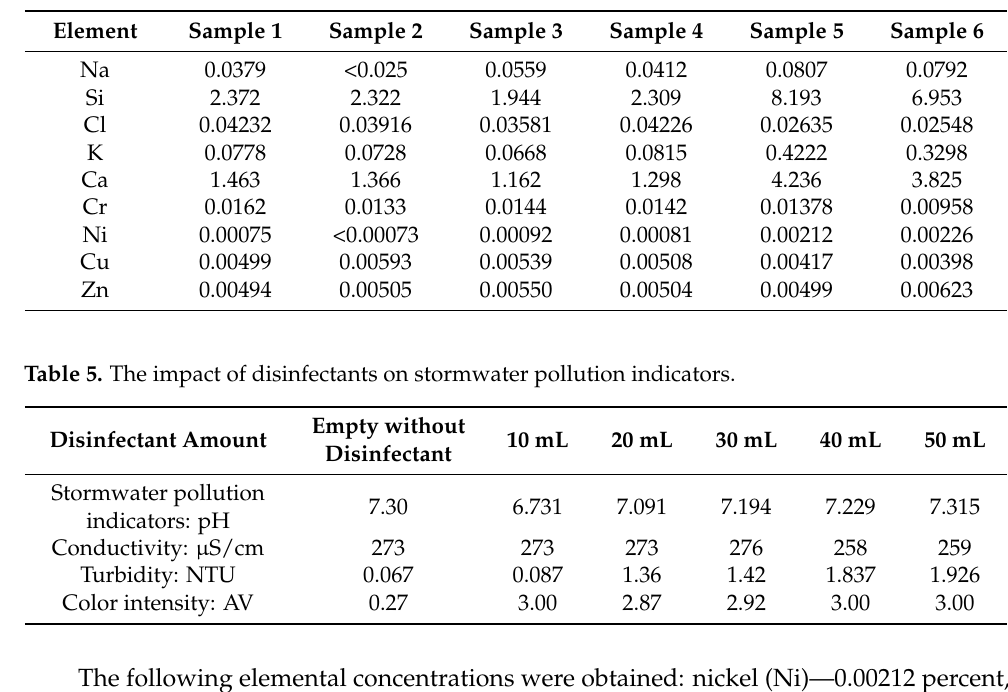
Table 4. Elements obtained in stormwater samples (concentration, %) (Trakai City, Vilnius Region).